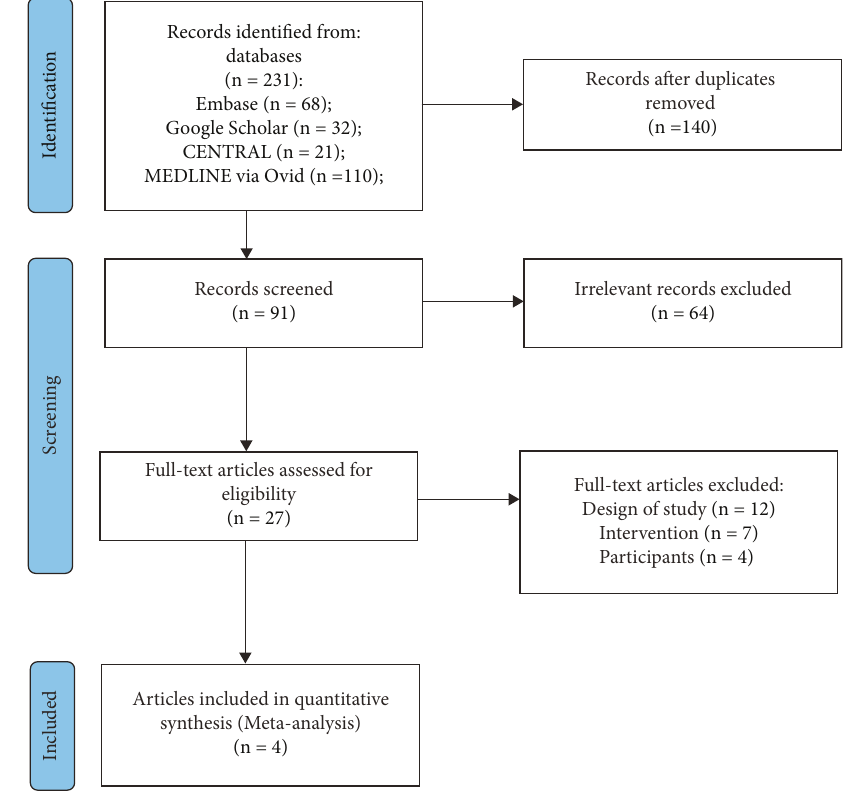
Figure 1: PRISMA flow diagram of included articles. Table 1: Characteristics of included